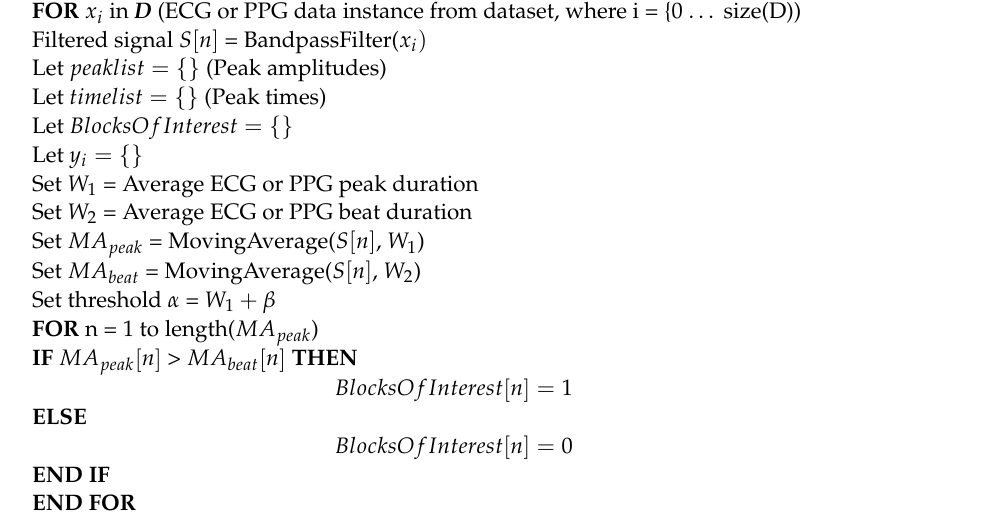
Algorithm 1. Pseudocode of peak detection algorithm and feature detection for dataset D